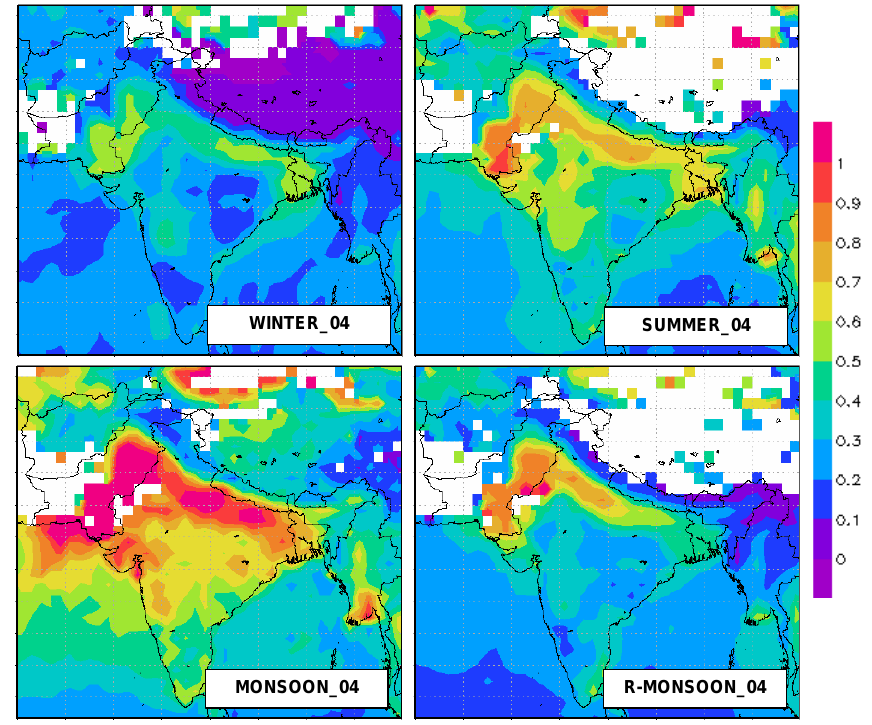
Fig. 9. Time averaged Terra aerosol optical depth at 0.55 µ m (Daytime) over the entire Indian zone at four representative seasons of the year Figure 9 : Terra aerosol optical depth at 0.55 µm (Daytime) at four representative seasons of the year 2004.